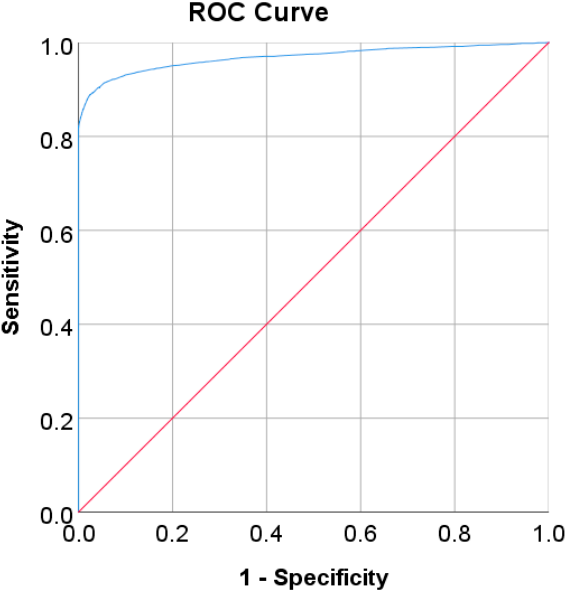
Figure 2. Sensitivity, specificity, PPV, and NPV for FPG in the Chinese adult population based on Figure 3. ROC curve for FPG values as a screening test on the Chinese diabetes dataset. FPG was ADA and WHO cut point recommendations compared to the optimal cut point. used as the gold standard; the straight line represents the reference line.